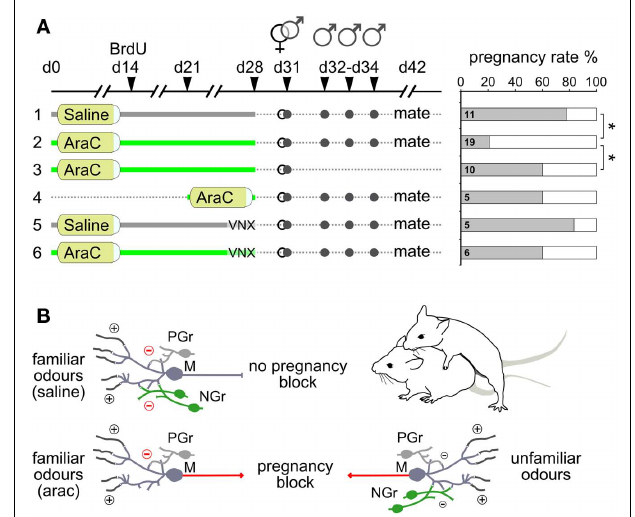
FIGURE 6 | Newborn granule cells in theAOB are necessary for mating partner recognition. (A) Matings and male stimulations on female mice after different protocols of Ara-C/saline treatment in normal and vomeronasal nerve-lesioned mice (VNX). Shown in the graph are the pregnancy rates (in percentage) as a function of the different treatment conditions evaluated 11days after mating. (B) Schematic diagram illustrating the role of AOB newborn granule cells (NGr) in the modulation of mate’s familiar signals (left side) and unfamiliar ones (right side): granule cells are preferentially involved in the detection of male individual odors once integrated into pre-existing circuits.When highly responsive newborn granule cells (NGr) are eliminated after Ara-C treatment (left side, bottom), pre-existing granule cells (PGr) are not sufficient to prevent pregnancy block by mate’s familiar odors (red arrows). *P < 0.05, ( Table 1